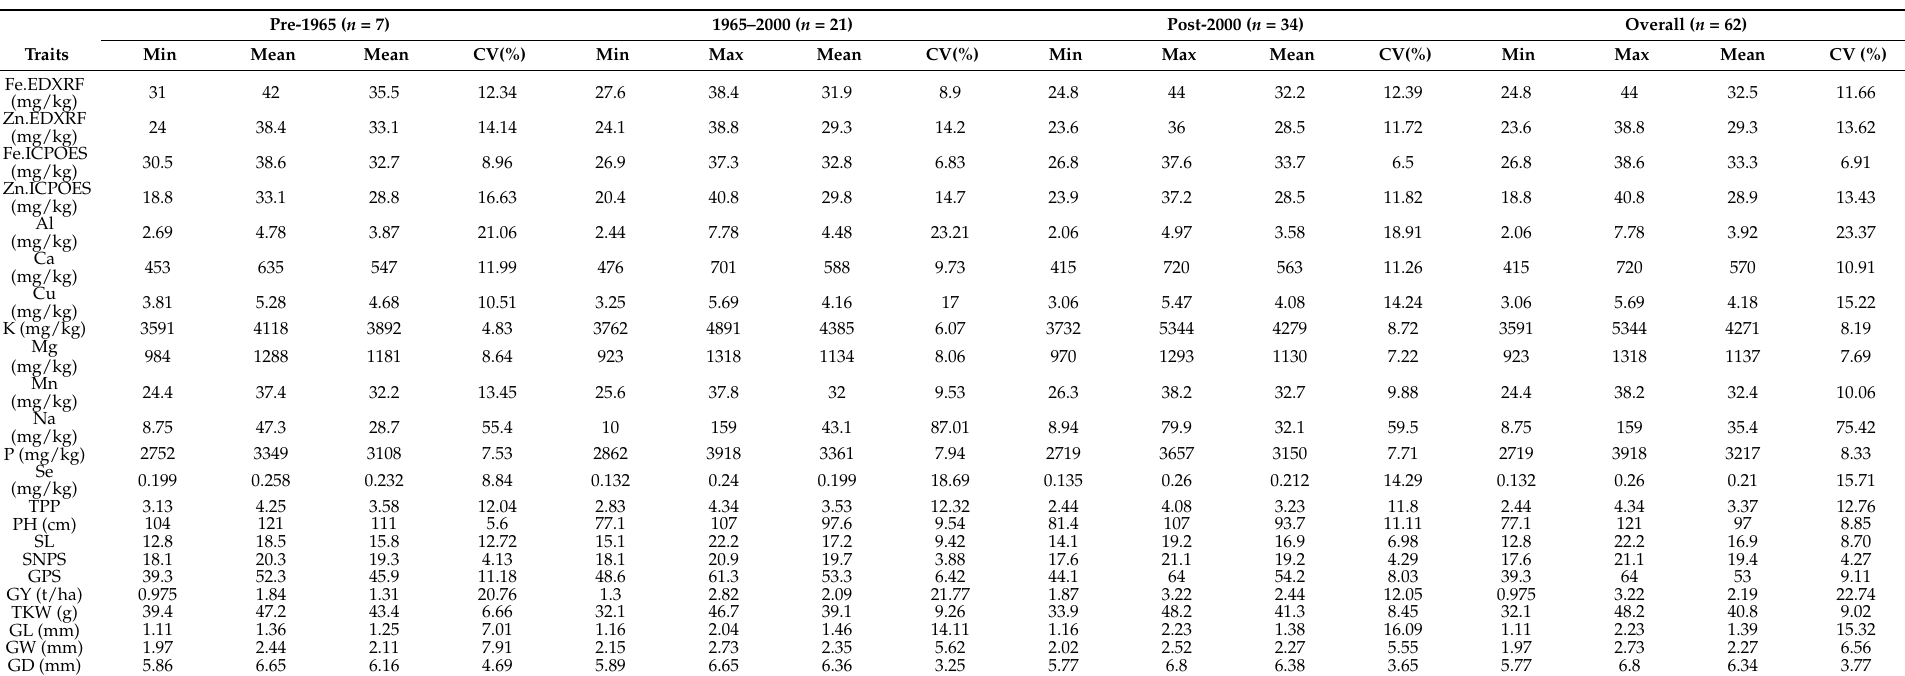
Table 2. Descriptive statistics of grain mineral elements and morphological traits in sixty-two wheat cultivars classified into three distinct breeding